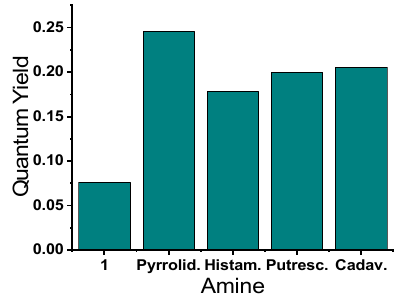
Figure 10. Quantum yield of different combinations between 1 and amines in DMSO; comparison between 1 without amine, pyrrolidine, histamine, putrescine, and cadaverine. After testing in different conditions, the best conditions for the experiments were determined to be as follows: three mackerel ( Scomber scombrus ) samples were bought in a local market, the fish were cleaned, the spines were extracted, and the muscle was ground (Philips HR 28308/B). Then, fish samples of 10 ± 0.2 g were placed in 20 mL vials and sealed with a septum. Half of the samples were incubated at 4 °C, and the other half were incubated at 25 ± 1 °C. Then, 3 mL of the gas phase of the vial was taken with a sy- ringe and bubbled into a probe solution at different times as the fish decayed over time. The absorbance and fluorescence of the samples were measured at their maximum peaks, and the differences between the obtained values and a reference solution were plotted (Figure 11). 0